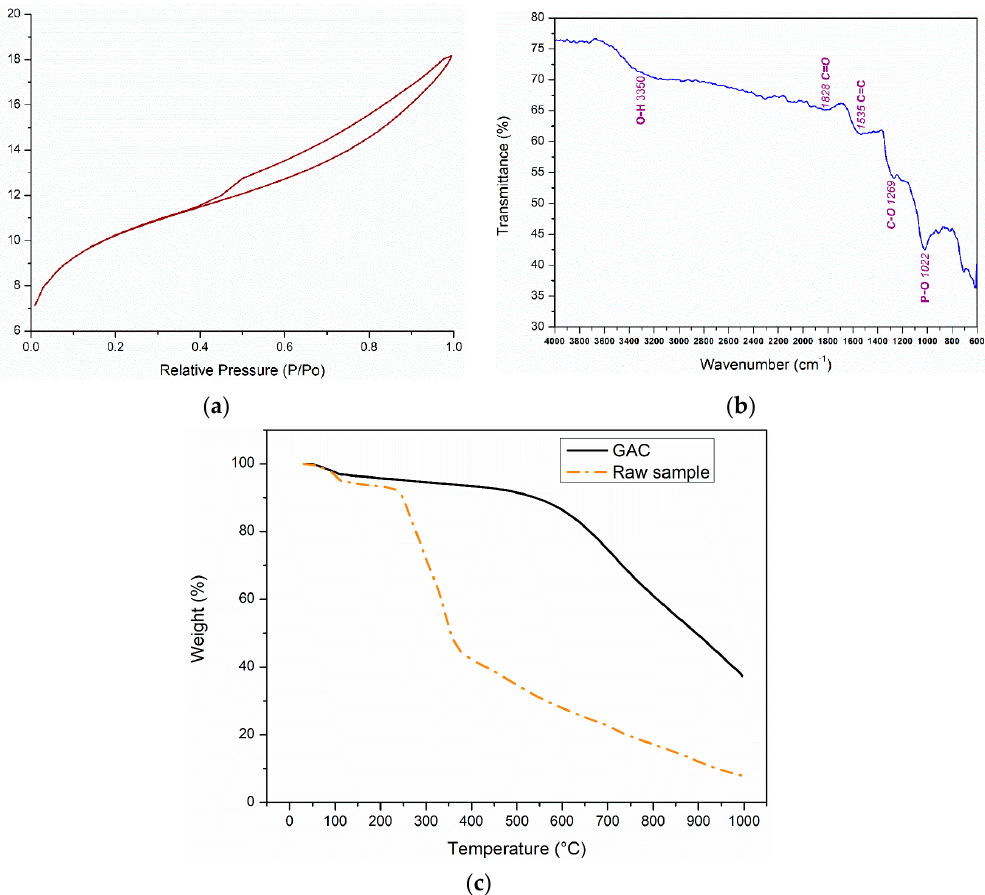
Figure 2. ( a ) The BET adsorption isotherm findings for the date palm-tree branches activated carbon (AC) (preparation conditions: 40% w/w phosphoric acid; impregnation ratio/R of 2 (R = (mL-acid/gm-